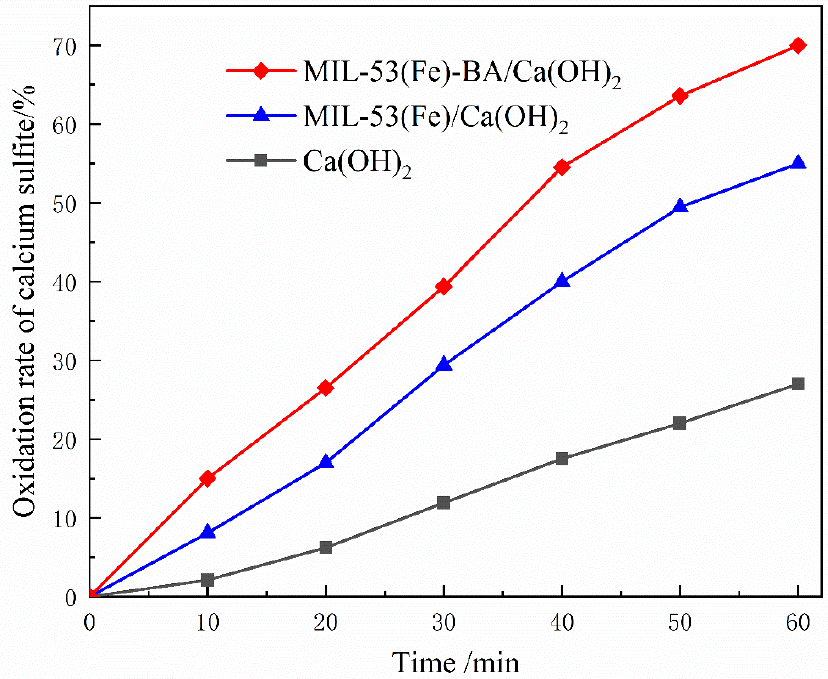
Figure 7. Catalytic oxidation of sulfite by MIL-53(Fe)-based additives.